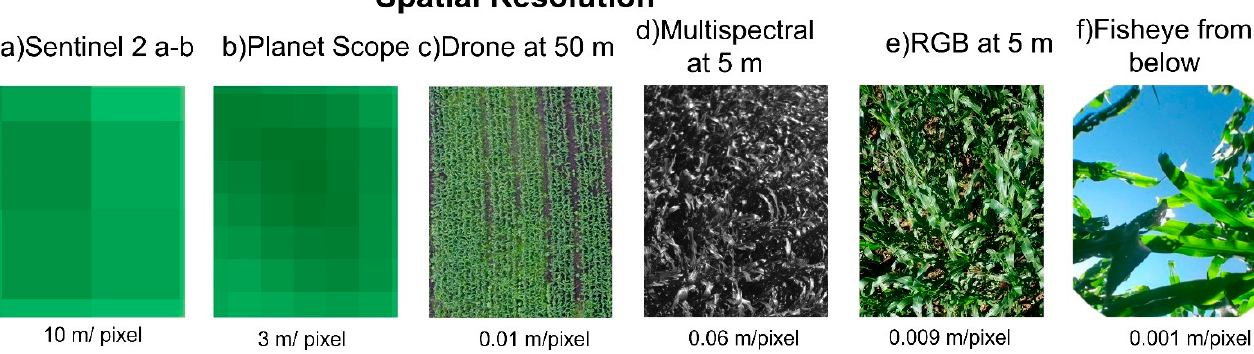
Figure 5. The different spatial resolutions that were used a long the article. ( a ) Calculated NDVI with Sentinel bands with a resolution of 10 m/pixel. ( b ) Calculated NDVI with PlanetScope bands with a resolution of 3 m/pixel. ( c ) Photo taken with a DJI Phantom 4 UAV at an altitude of 50 m and with a resolution of 0.01 m/pixel. ( d ) Photo taken with a multispectral camera at 5 m of altitude and with a resolution of 0.06 m/pixel. ( e ) Photo taken with a RGB camera at 5 m of altitude, and with a resolution of 0.009 m/pixel. ( f ) Photo taken with a mobile phone with a fisheye adapter from below, and with a resolution of 0.001 m/pixel.